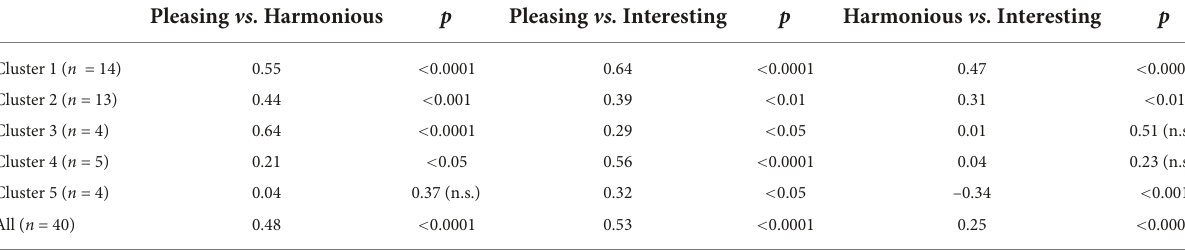
TABLE 5 Average Spearman’s coefficients ( ρ ) for the correlations between the different rating dimensions (Pleasing, Harmonious, and Interesting) for the five groups of participants that were clustered on the basis of the inter-rating correlations. Pleasing vs. Harmonious p Pleasing vs. Interesting p Harmonious vs.